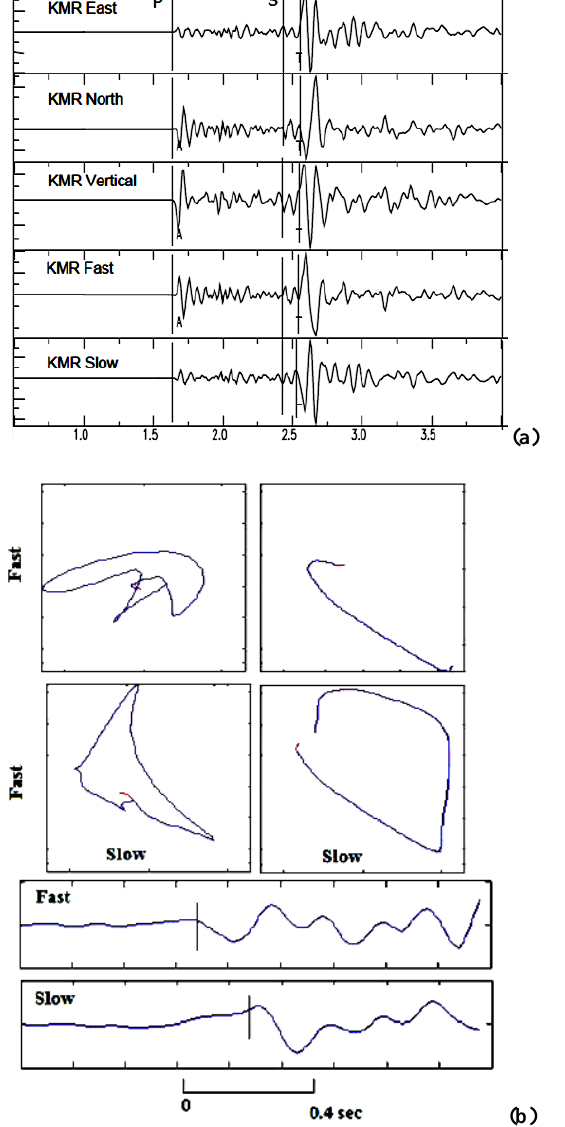
Fig. 4. (a) Screen image from shear wave splitting analysis be- fore Splitting processing. Three-component seismogram at a rate of 100 samples per second of a magnitude 2.8 earthquake recorded at Station KMR of TURDEP seismic network in Marmara. Time axis is in seconds. From top to bottom, seismograms are EW-, NS- , vertical-, and rotated horizontal components respectively. P- and S-wave arrivals from the study seismic catalogue are also marked on the original seismograms. (b) Screen image of polarisation di- agrams for possible adjustment of polarisation and time-delay is shown. Fast and slow shear-wave picks are shown in horizontal po- larisation diagrams in time interval 1S and 2S. First and last points of time-delay and directions are determined by visual adjustment.